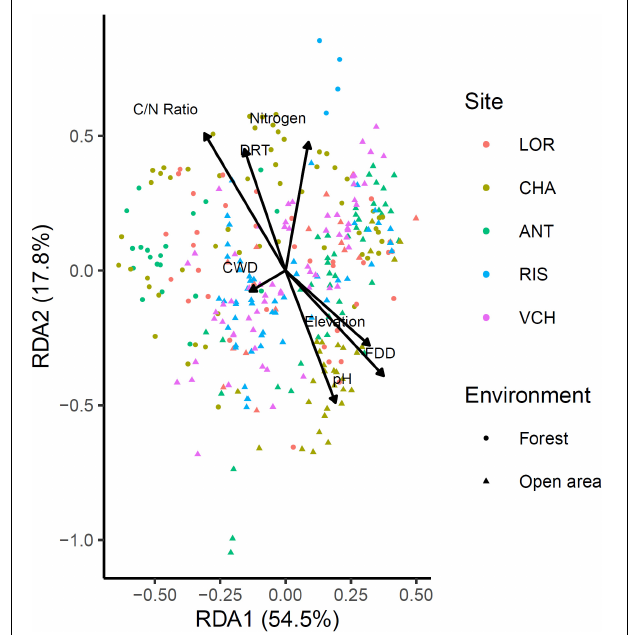
against seven environmental (Nitrogen, Elevation, C/N ratio, pH) and bioclimatic (DRT, CWD, FDD) variables.